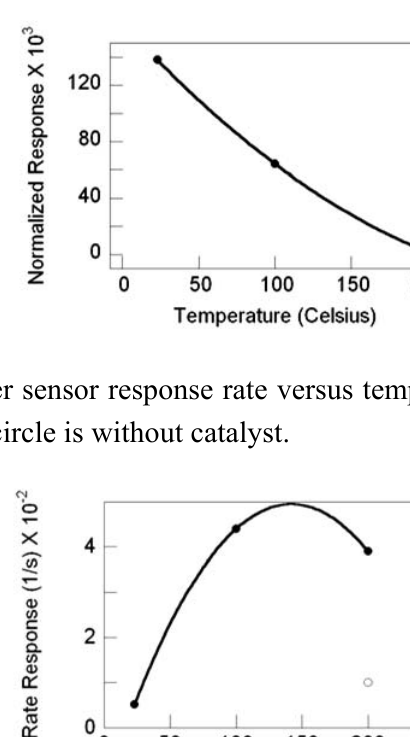
Figure 25. SnO nanofiber sensor response versus temperature, filled circles are with Pd 2 catalyst, the nonfilled circle is without catalyst.